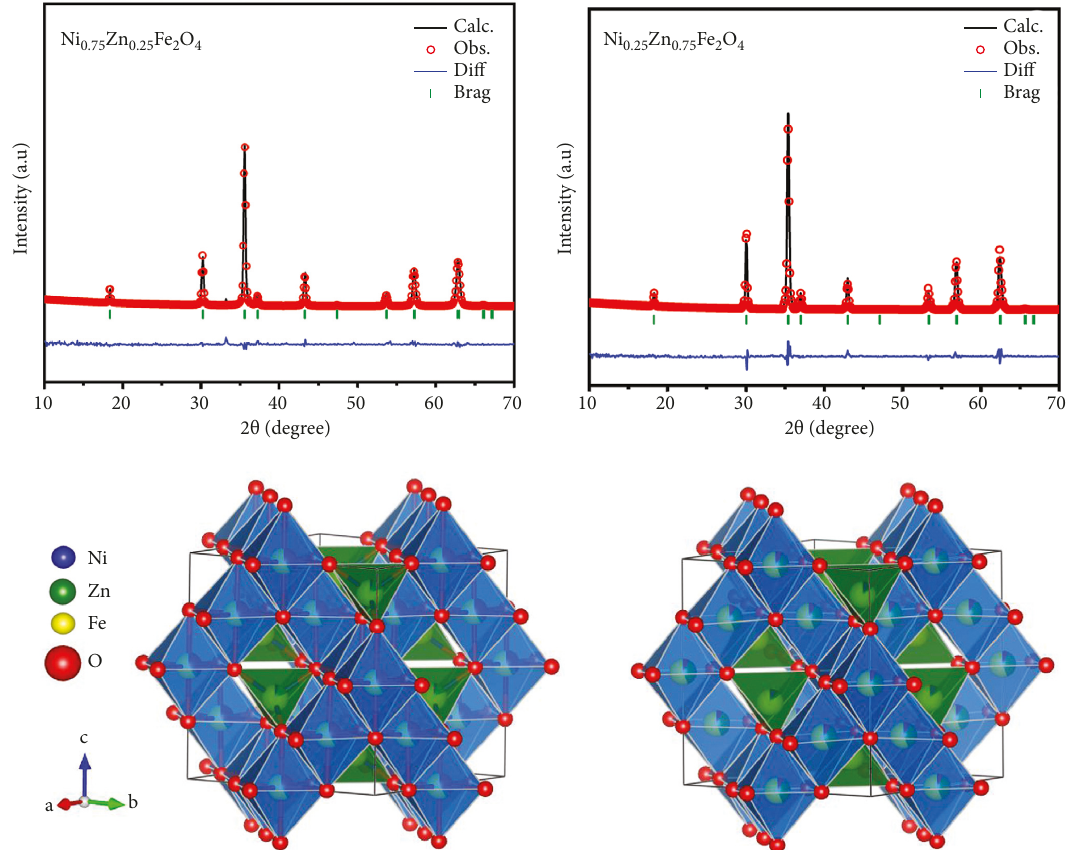
Figure 7: The Rietveld refinements of Ni ° C. The diagrams in the second row show the 0.75 Zn 0.25 Fe 2 O 4 and Ni 0.25 Zn 0.75 Fe 2 O 4 annealed at 750 polyhedral structure of the samples. Table 2: Rietveld-derived cation distribution, profile factor ( R p ), weighted residual factor ( R wp ), expected residual factor ( R exp ), and